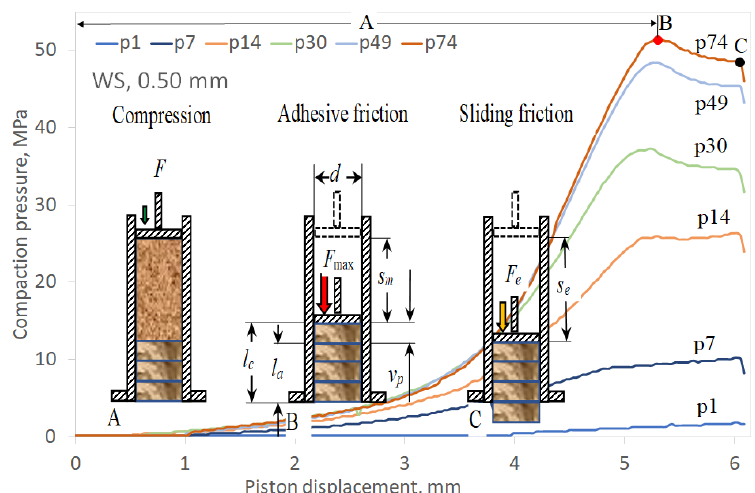
Figure 1. Schematic of sample pelleting cycle on background of selected curves of compaction pressure vs. piston displacement: ( A ) start of compaction of a new material dose, ( B ) attaining maximum compaction force/pressure, and ( C ) shift of currently compacted pellet along with agglomerate located under it. d —die (pellet) diameter, l a —agglomerate length, l c —real die height, s m — piston displacement at maximum agglomeration pressure, s e —end of piston displacement, v p —pellet shift in the die, F , F max , and F e —compaction forces: current, maximum, and pellet shift, respectively.